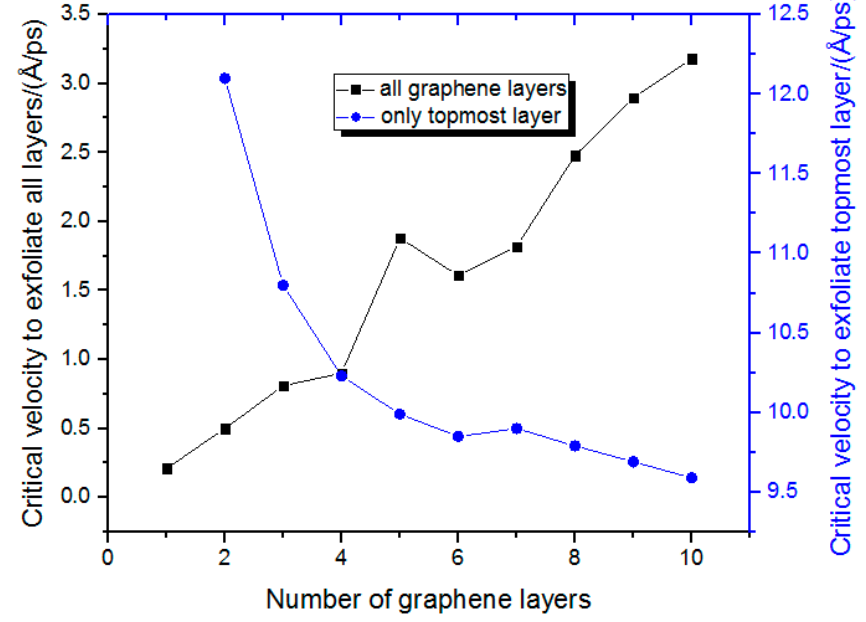
Figure 13. The critical velocities to exfoliate graphene.